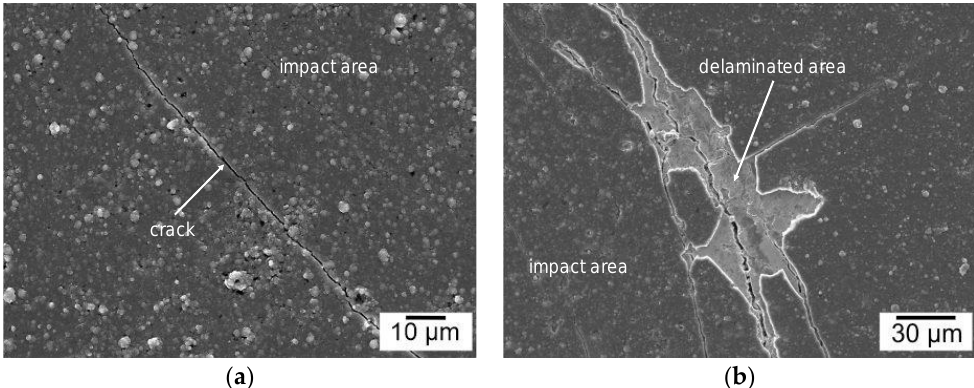
Figure 11. Failure patterns in the outer edge of the impact zone for St-B-C: ( a ) Impact area and crack for the impact created at 2 kN and 1 load cycle; ( b ) Outer edge of the impact zone with significant crack patterns and coating delamination after being subject to 10 5 cycles at 4 kN.